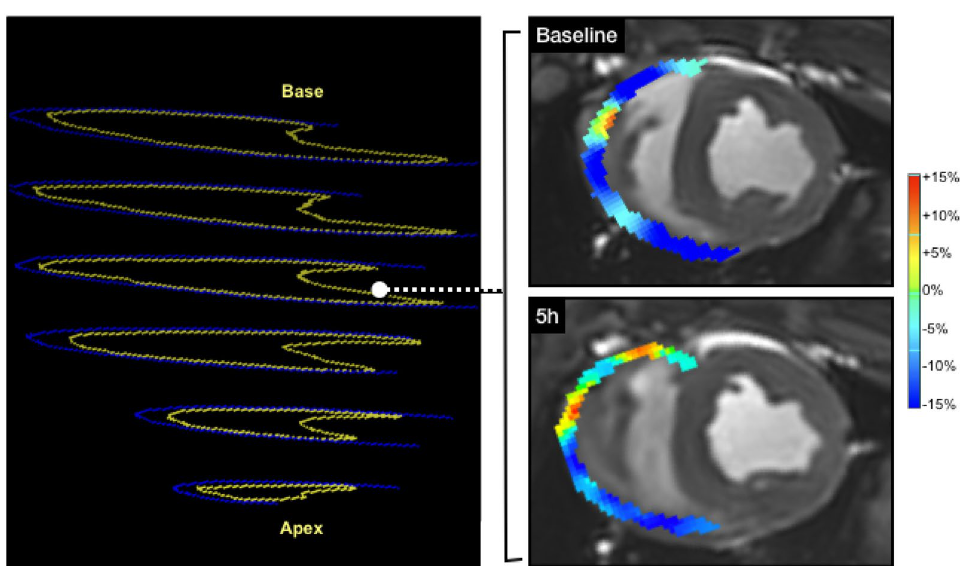
Figure 5. Impact of electrical interventions on the RV. Left: slice positions of the right ventricle (endocardium = yellow, epicardium = blue). Right: circumferential strain at end-systole indicating a worsening in strain (yellow-orange) 5 h after electrical